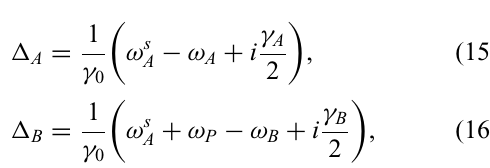
FIG. 2. (a) Schematic of a circuit containing two reso- nant modes coupled through a time-varying mutual inductance pumped at a frequency ω P . (b) Coupled-mode graph of a two- mode parametric converter and the corresponding equation-of- ], b [ ω s ] ) T . (c) motion matrix, written in the basis (cid:6) v = ( a [ ω s B A Coupled-mode graph of a two-mode parametric amplifier and the corresponding equation-of-motion matrix, written in the basis (cid:6) v = ( a [ ω s ], b ∗ [ − ω s ] ) T . B A Eq. (5) as